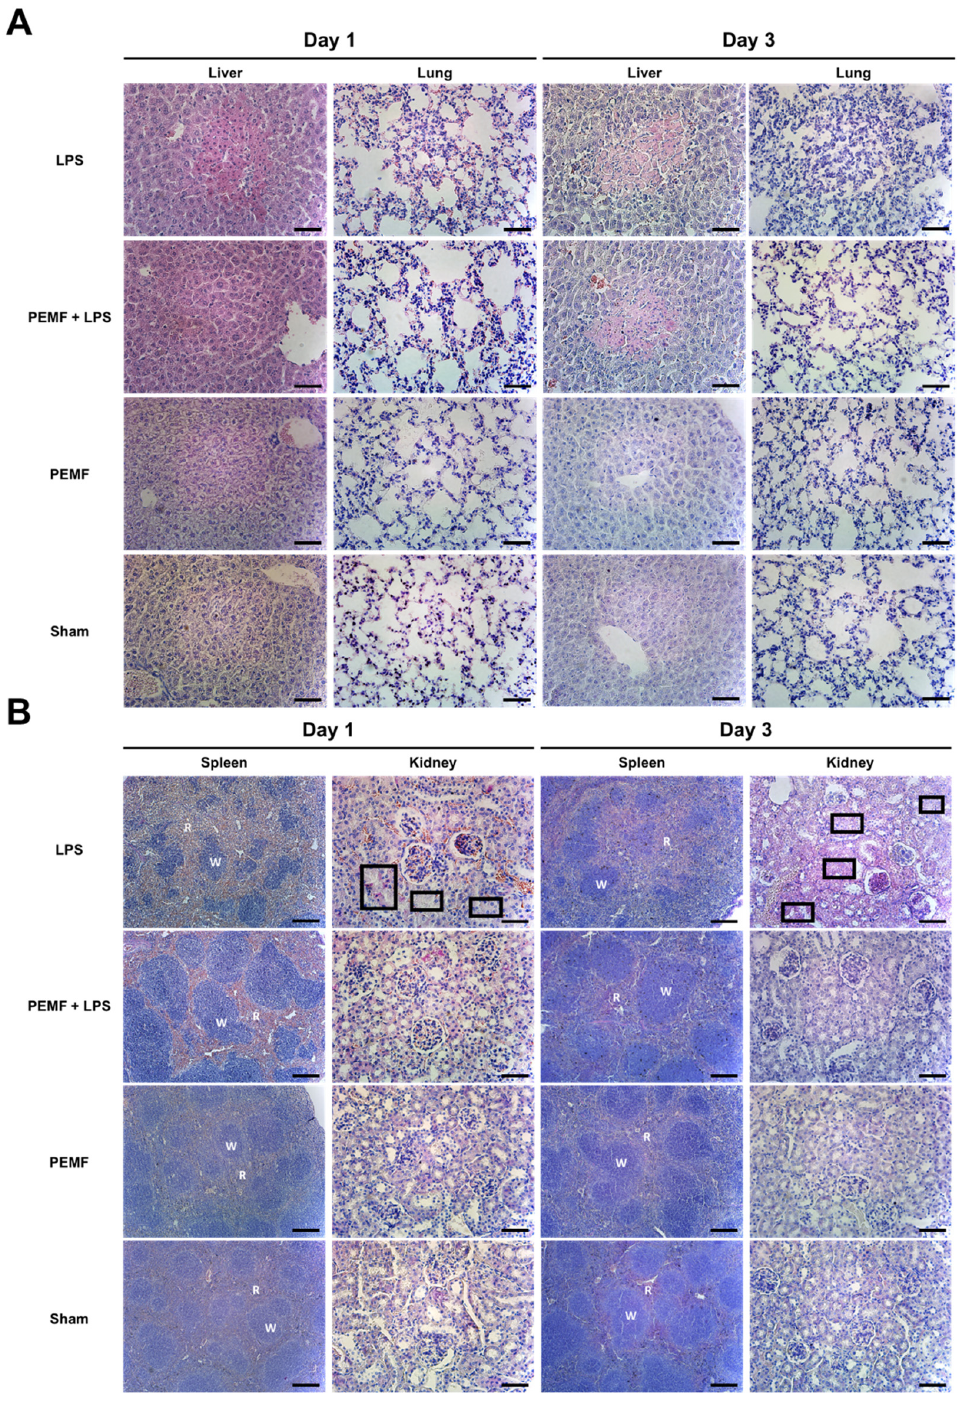
Figure 5. Effect of PEMF treatment on tissue damage in septic shock-induced mice. Formalin-fixed paraffin-embedded samples from each group of mice on day 1 and day 3 were stained with hematoxylin and eosin (H & E). Representative images of ( A ) liver and lung, and ( B ) spleen and kidney are shown. Black boxes depict damaged area. W, white pulp; R, red pulp. Scale bar = 100 μ m.